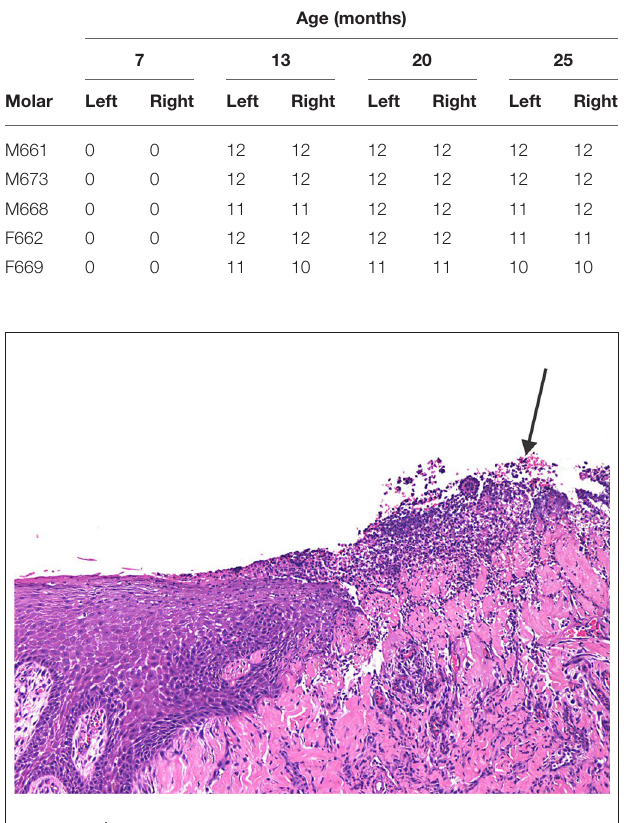
FIGURE 9 | The photomicrograph shows ulcerated epithelium (arrow) with mixed inflammation extending deep into the underlying connective tissue of the inflamed palatal